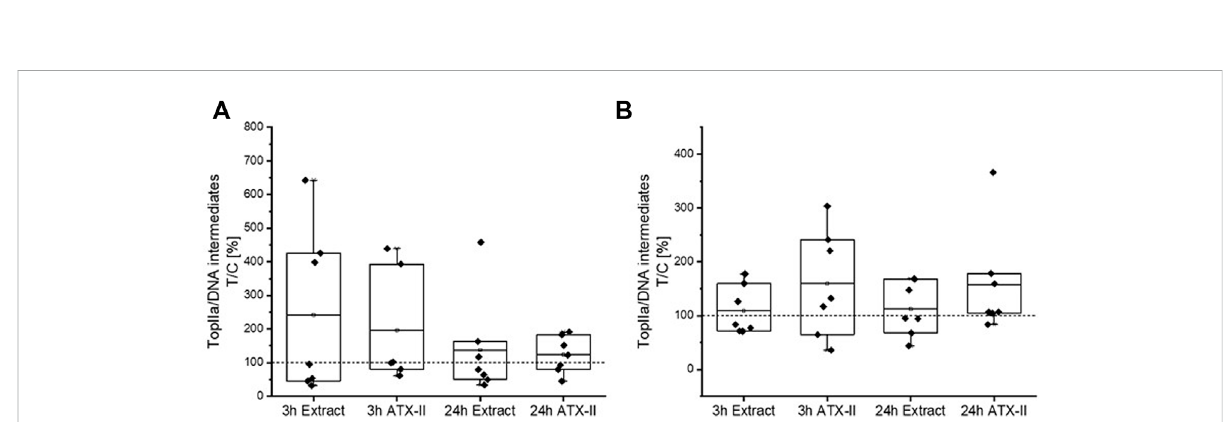
FIGURE 7 TheamountoftopoisomeraseIIa(Top-II α )boundtotheDNAin (A) colonor (B) livertissueofratsthatwereexposedtoaltertoxin-II(ATX-II)orto a complex extract of Alternaria toxins (CE). Graphs show ICE assay results of 7 rats per group, normalized to the control group (dotted lines) and as boxplotsincludingsingleresults(blacksquares).Testingforsigni fi cantdifferencestotherespectivecontrolgroupbyone-wayANOVAdidnotreveal positive